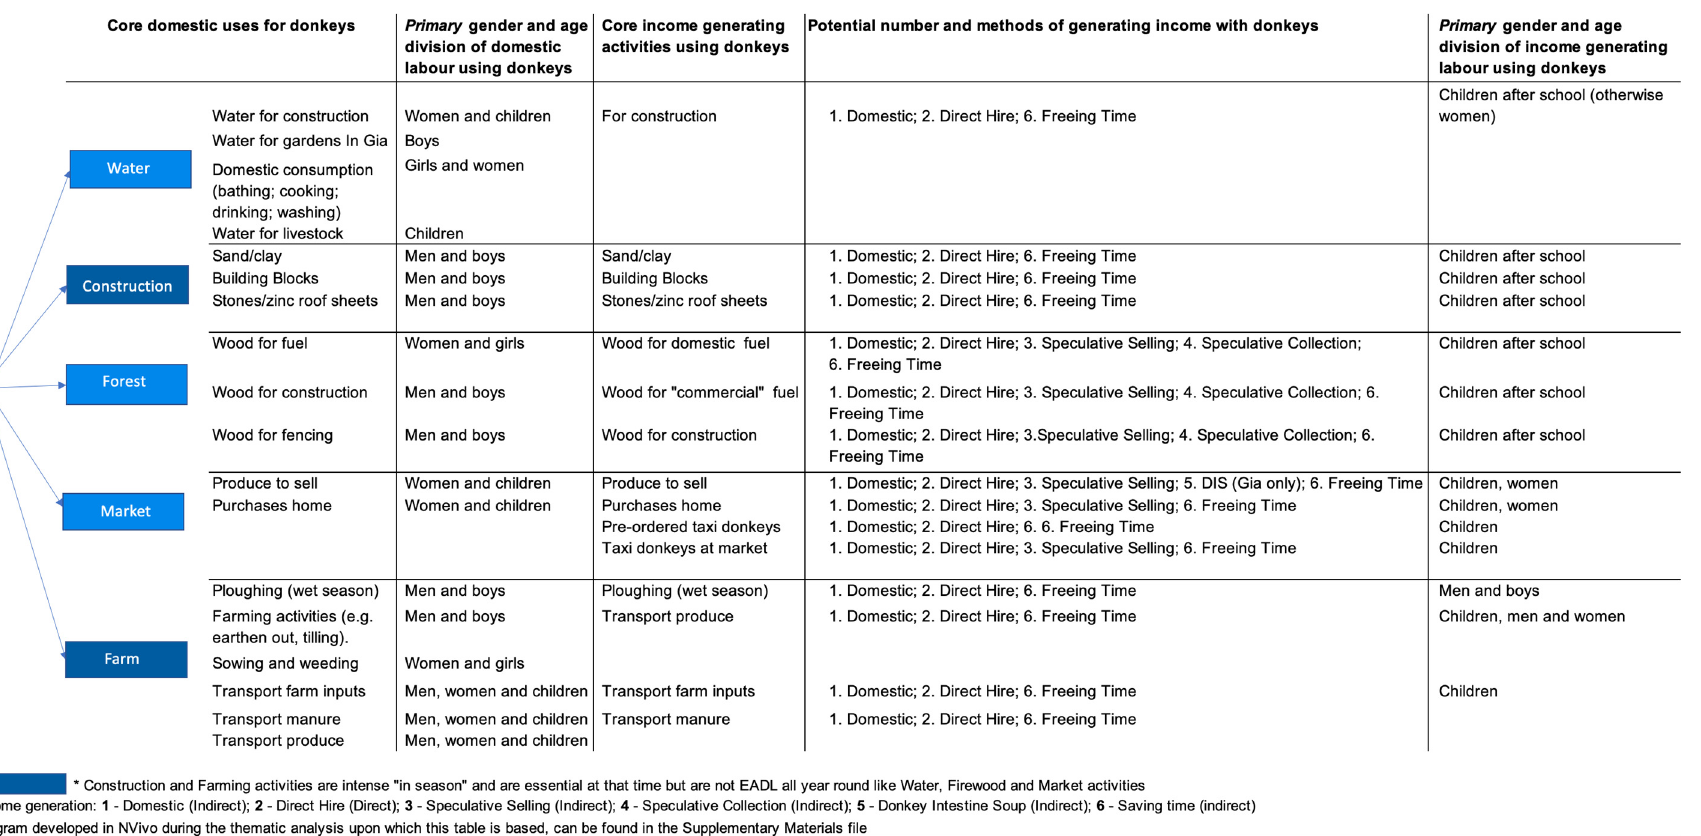
Figure 4. Division of age and gender related Essential Activities of Daily Living across domestic and “commercial” uses of donkeys.